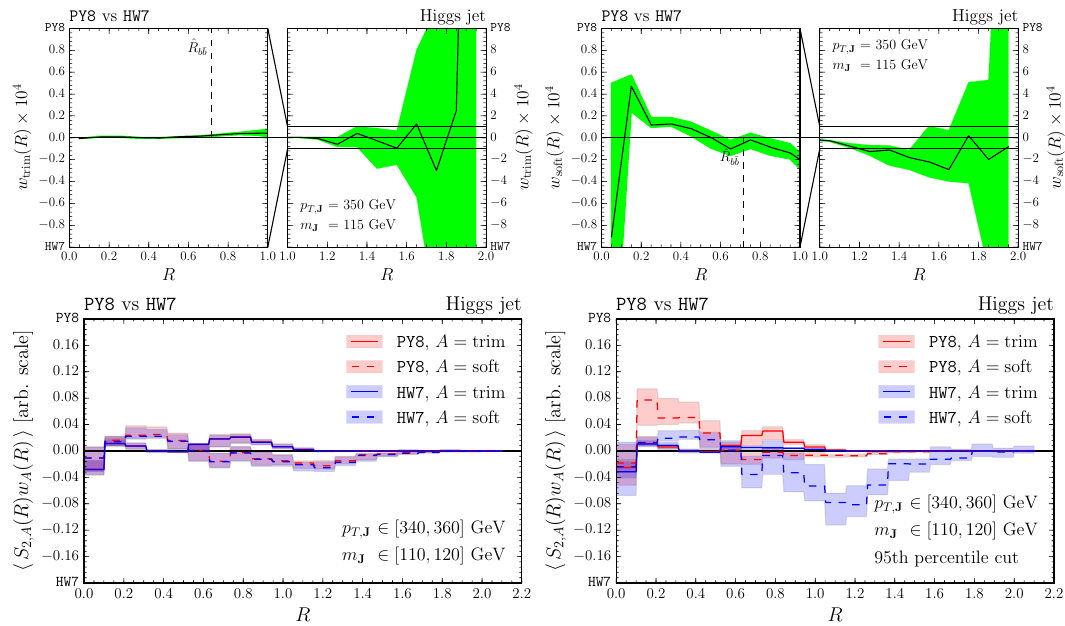
Figure 17 . Top (cid:12)gures are the weights w trim (left) and w soft (right) at p T; J = 350 GeV and m J = 115 GeV for classifying Higgs jet of PY8 and HW7 events. Bottom (cid:12)gures are In the right bottom (cid:12)gure, we additionally demand that ^ y 1 of the PY8 generated jets and ^ y 2 of the HW7 generated jets are larger than their 95th percentile respectively. We show their statistical uncertainty from the training samples as colored